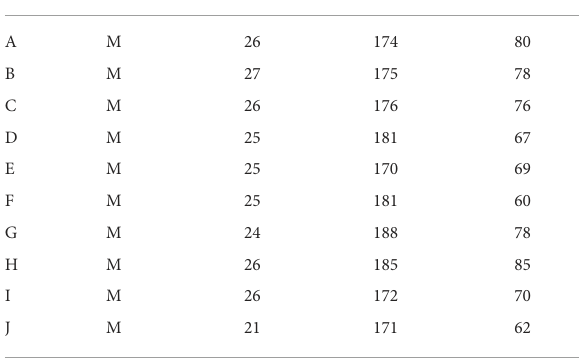
TABLE 1 Participants’ demographic